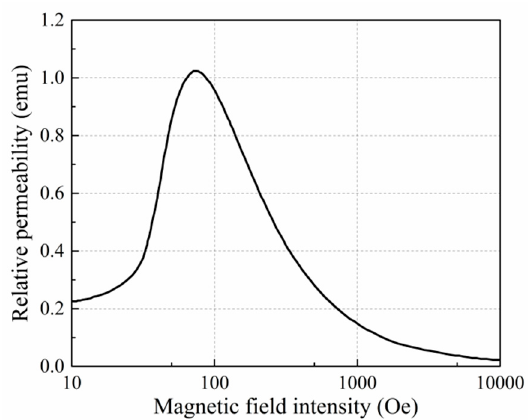
Figure 7. Equivalent magnetic model of the DSLRPMM with Maxwell’s resultant flux.